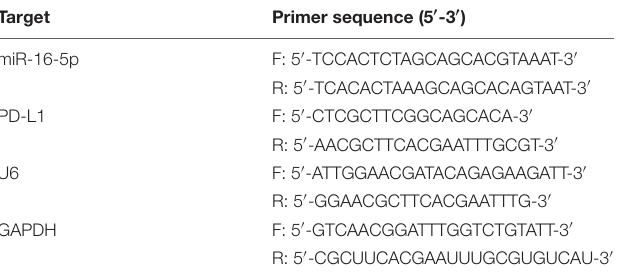
TABLE 1 | Primer sequences for